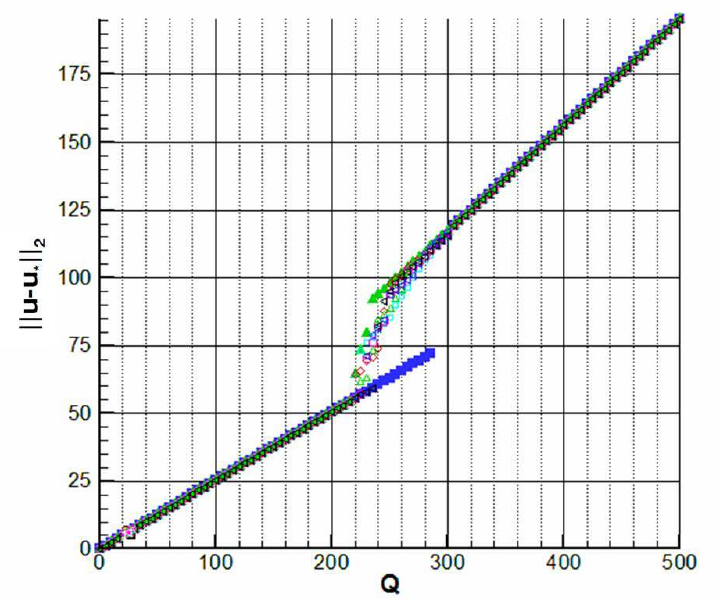
Figure 7. Approximated { ( Q , || u − u ∗ || 2 ) } diagram for the coupled model.